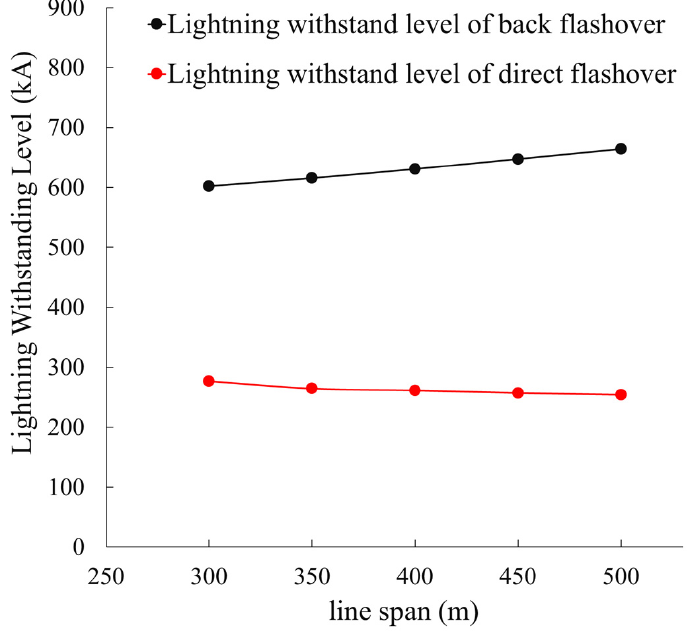
Figure 6. Influence of line span on LWL.